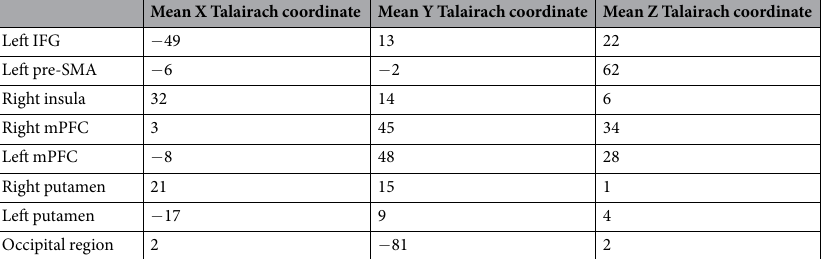
Table 3. Regions of interest (ROIs) used as seeds in seed-based correlation analysis. Mean Talairach coordinates (center of gravity) for seeds used in seed-based correlation analysis are presented.